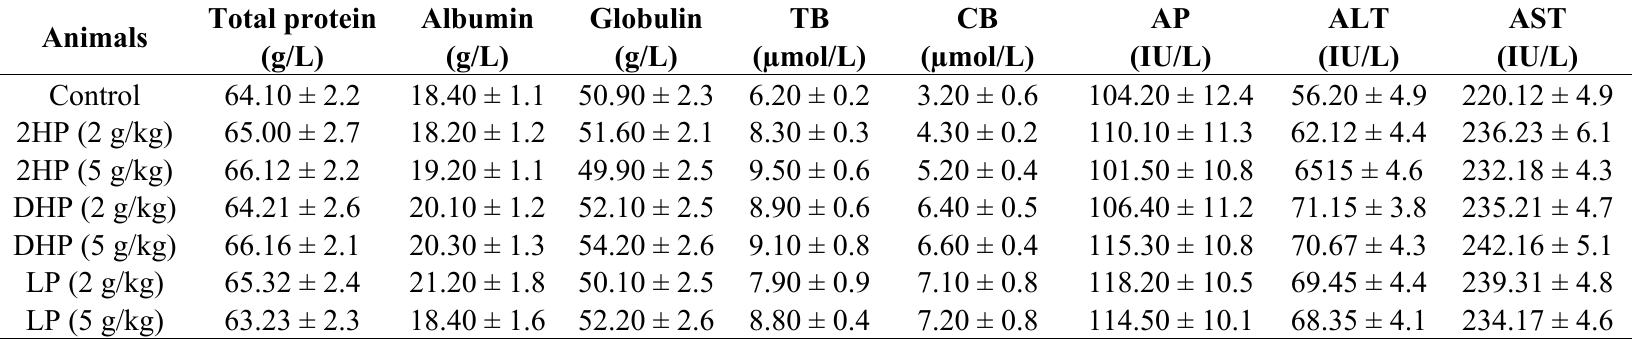
Table 3. Liver function test of rats used in acute toxicity assessments of 1-(2-ketoiminoethyl)piperazine Schiff bases.